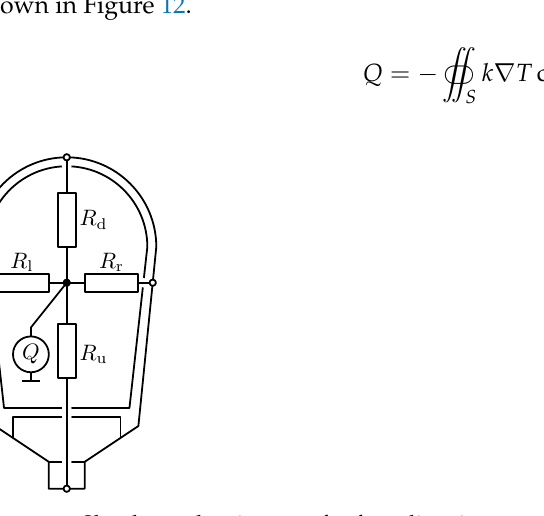
Figure 12. Slot thermal resistances for four